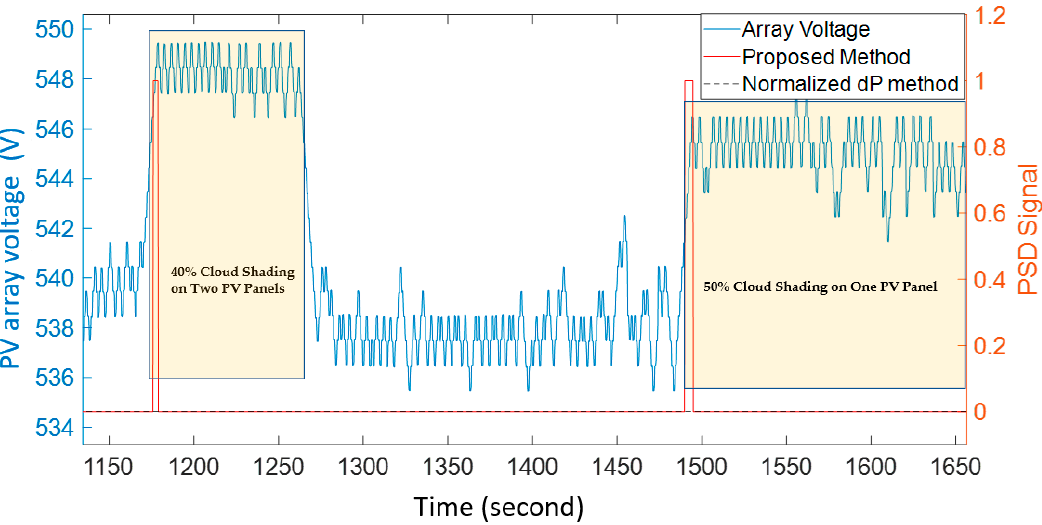
Figure 9. Series PV array voltage waveforms and PSD signals during the cloud shading simulation.